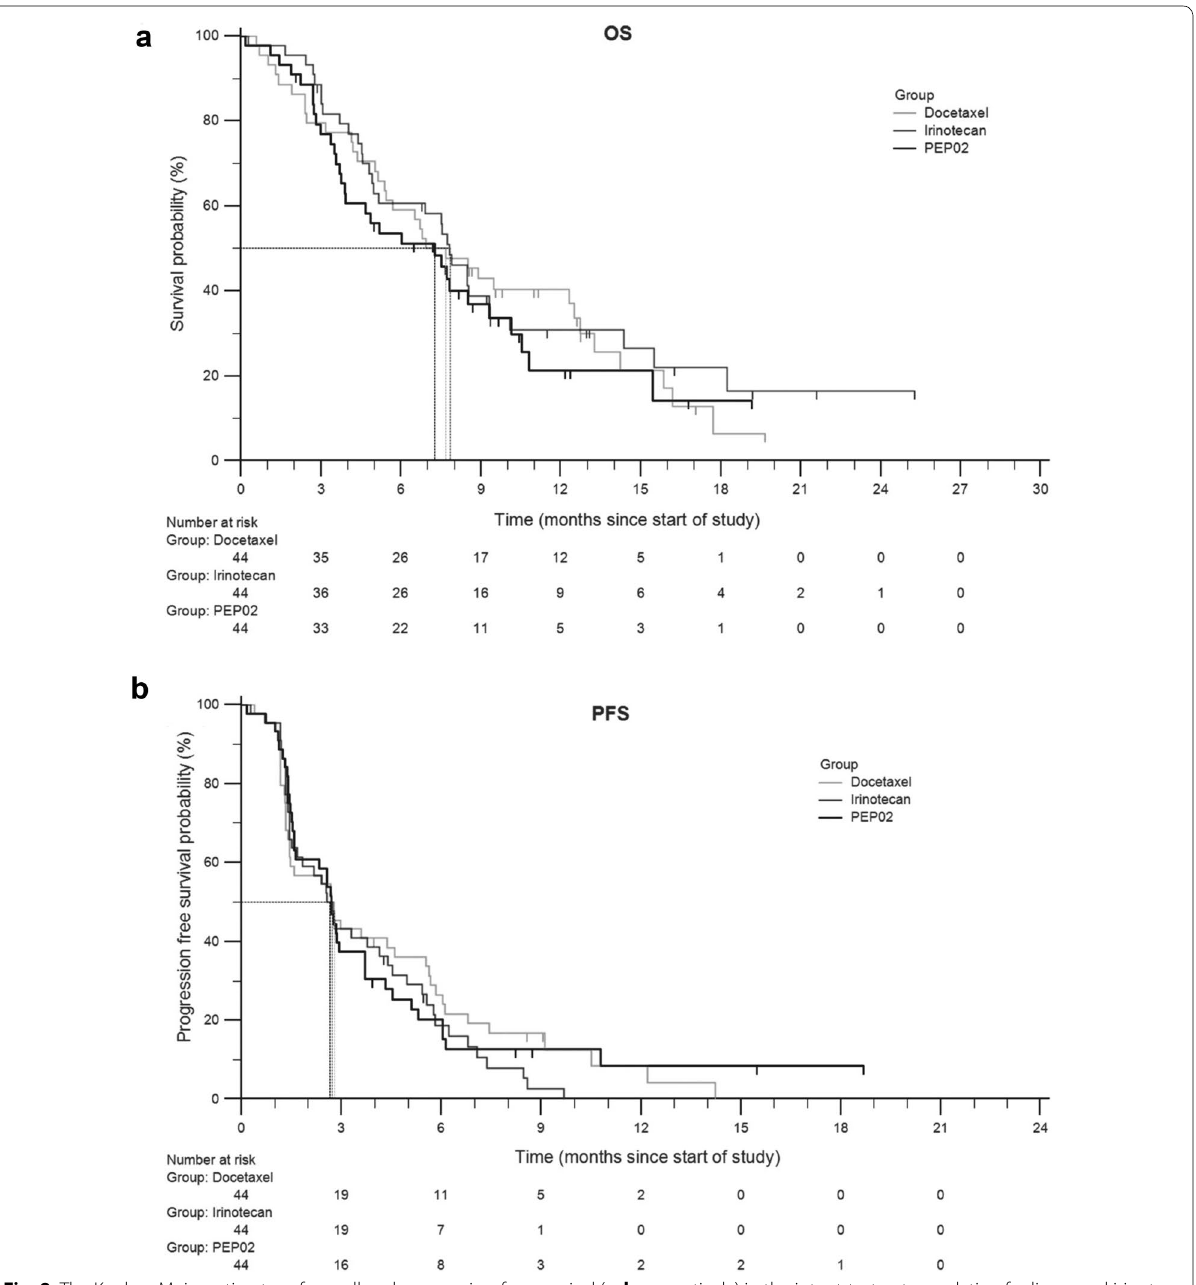
Fig. 8 The Kaplan–Meier estimates of overall and progression‑free survival ( a , b respectively) in the intent‑to‑treat population for liposomal irinote‑ can (PEP02), irinotecan, and docetaxal (Reproduced with permission from